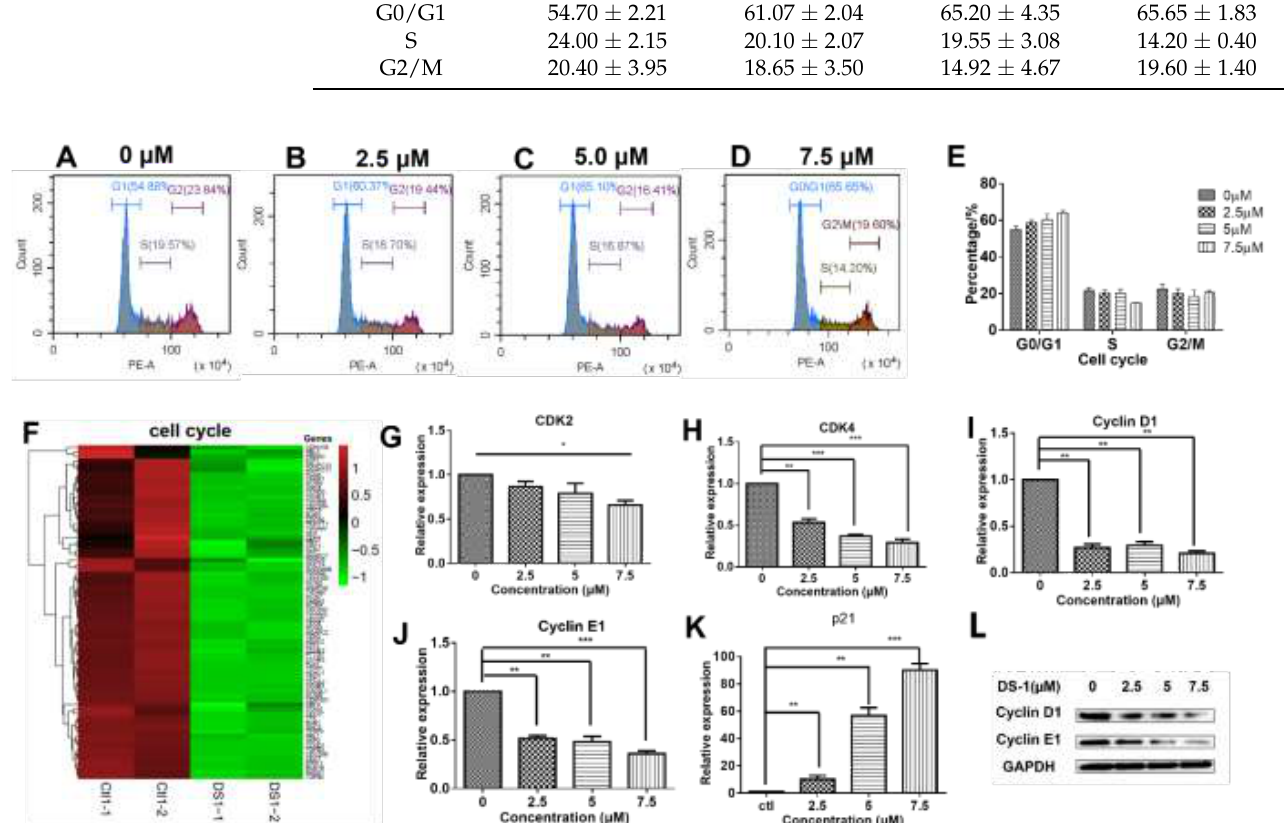
Figure 5. DS − 1 regulated the cell cycle of U − 2 OS cells. ( A – D ) Cell cycle of U − 2 OS cells was retained in the G0/G1 phase. U − 2 OS cells were treated with DS − 1 at 0, 2.5, 5.0, and 7.5 µM for 24 h, and the cell cycle ratio was measured by flow cytometry; the cell cycle distribution is shown in Table 2. ( E ) Histogram of cell cycle distribution after U − 2 OS cells were treated with DS − 1. ( F ) Heatmap of the expression of genes relating to cell cycle in the transcriptome results. ( G – K ) In U − 2 OS cells treated with DS −1 at concentrations of 0, 2.5, 5.0, and 7.5 μM, RNA was extracted and analyzed by RT-PCR, and the changes in CDK2, cyclin D1, cyclin E1, and p21 mRNA are presented in the histogram. ( L ) Cyclin D1 and cyclin E1 protein relative expression was analyzed by Western blot. Values are the average of three independent experiments, * p < 0.05, ** p < 0.01, *** p < 0.005.